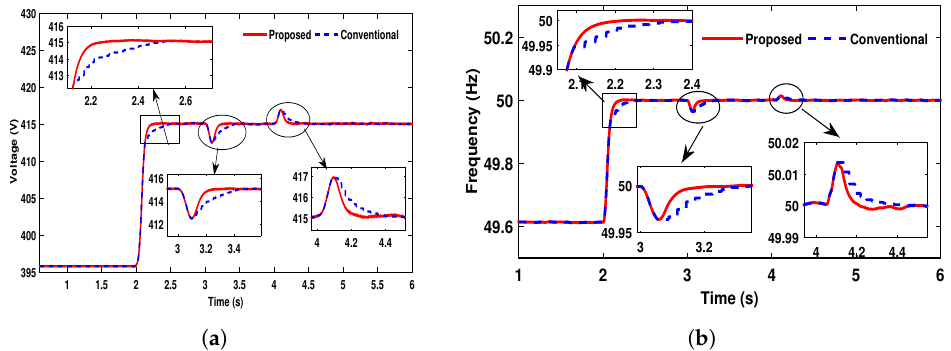
Figure 12. Comparative analysis. ( a ) Voltage magnitude. ( b )